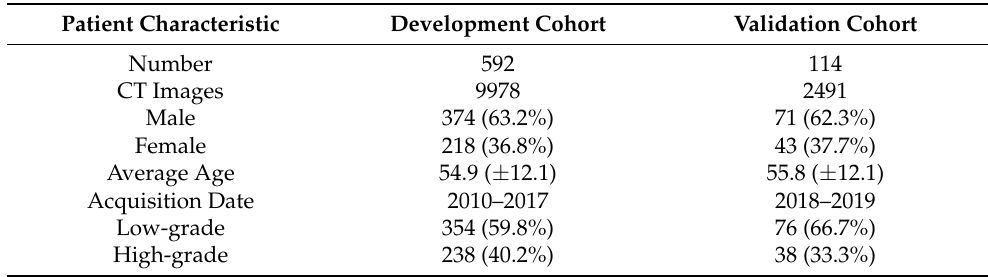
Table 1. Patient